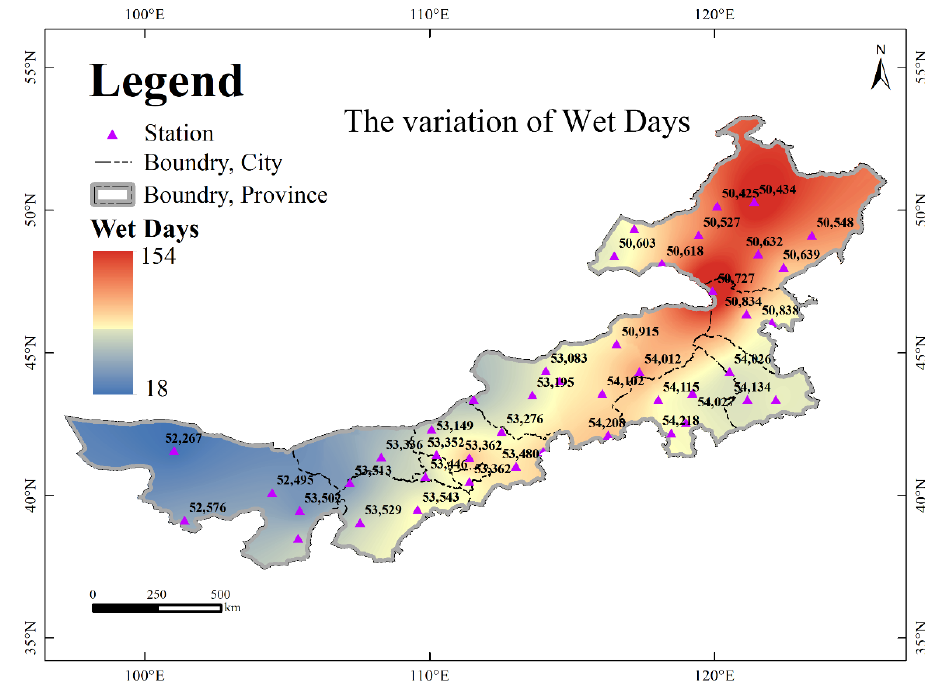
Figure 5. Spatial distribution of the mean wet days.